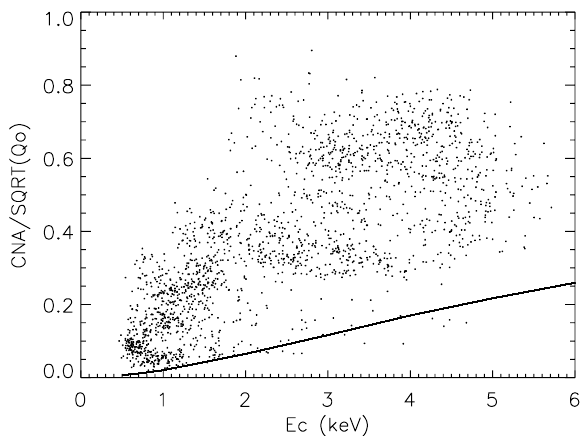
Fig. 4. Scatter plot of all CNA measurements shown in Fig. 3 against characteristic energy E c . The format of this figure is the same as that of Fig. 2. Unlike the case of Fig. 2, the observed CNA is distributed significantly above the theoretically estimated curve (solid line).